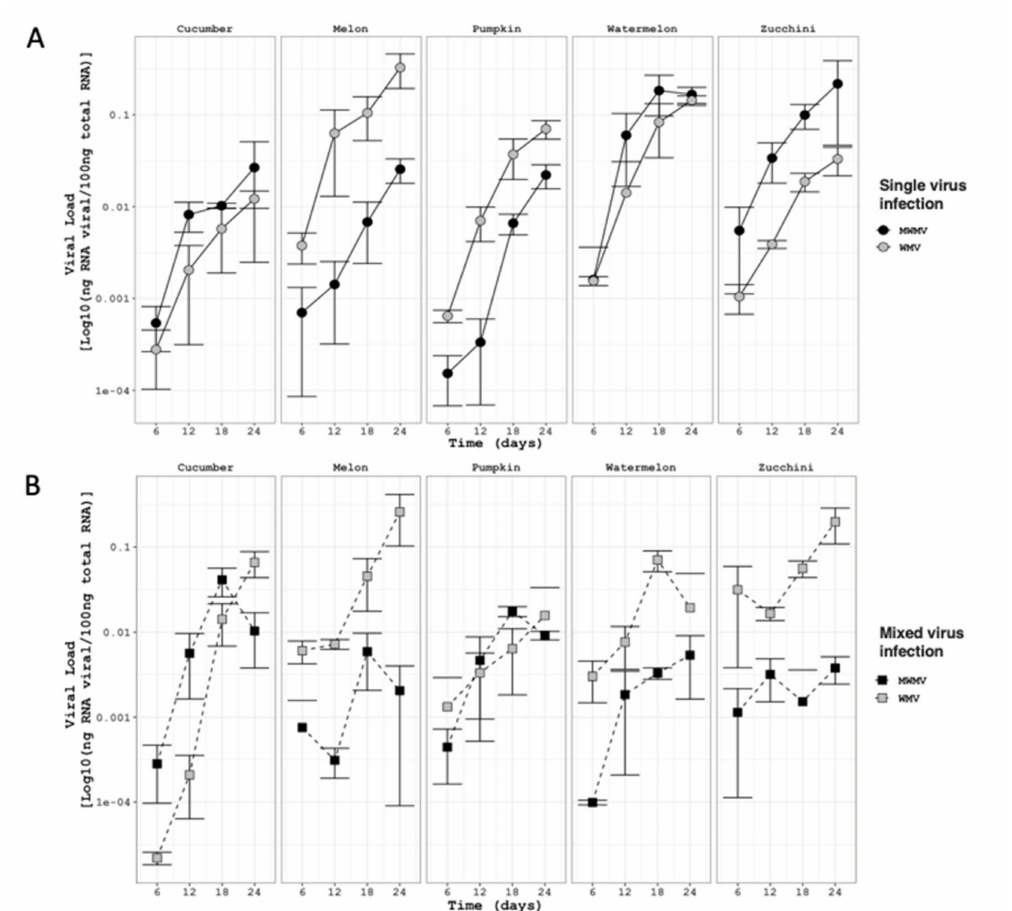
Figure 4. RNA viral load (Log10 (ng of viral RNA/100 ng of total RNA) mean and SE error bars, n = 3) of WMV-MeWM7 (grey) and MWMV-ZuM10 (black) in five different cucurbit plants under single ( A , circles) and mixed infections ( B , squares) during a time-course experiment. Viral accumulation of each clone was inferred by absolute quantification (RT-qPCR). RNA transcripts of the P1 gene were used in serial dilutions (10-fold) to generate external standard curves. RNA concentration was estimated from the threshold cycle (CT) values obtained from three independent plant samples, with three technical replicates for each sample, at each time-point (6, 12, 18, and 24 days